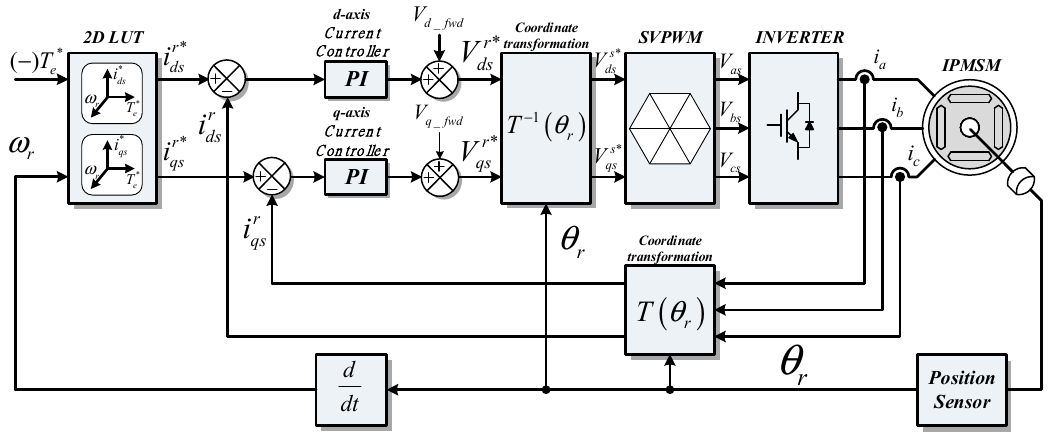
Figure 5. General regenerative torque control in a PMSM drive.